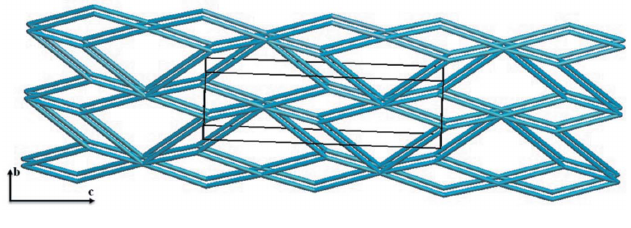
Figure 5 Simplification of the coordination framework in the two compounds using standard representation for valence-bonded CPs.